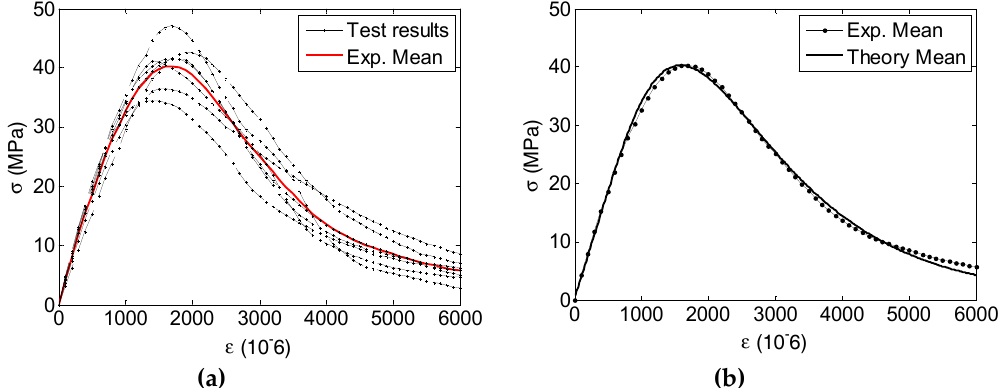
Figure 8. Stress-strain curves under uniaxial compression: ( a ) the stress-strain curves of seven prisms and a mean stress vs. strain curve; and ( b ) comparison of expected experimental and theoretical results with the best-fit parameters.